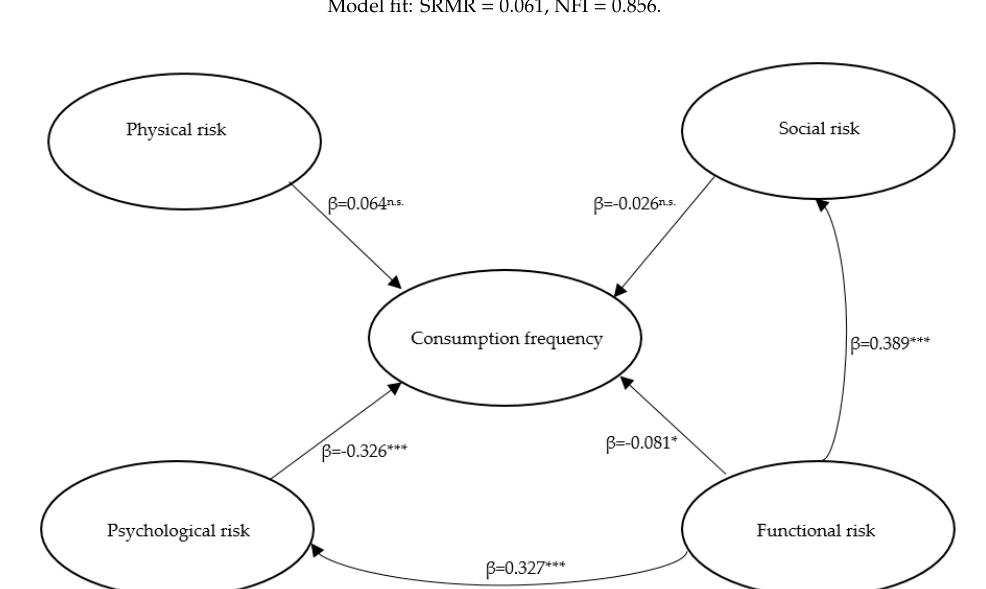
Figure 3. Results of structural equation modeling. β = standardized regression coefficient; * p < 0.05, *** p < 0.001, n.s. not significant.